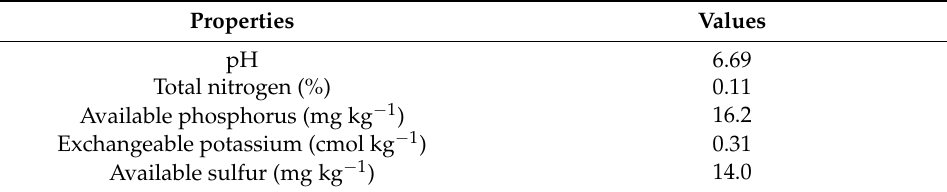
Table 1. The chemical properties of soil (0–15 cm) of the experimental field.